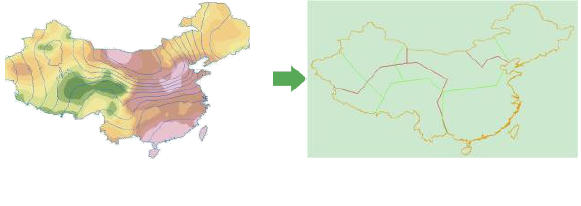
Figure 5. Extract the regionalization boundaries dominated by climate factors